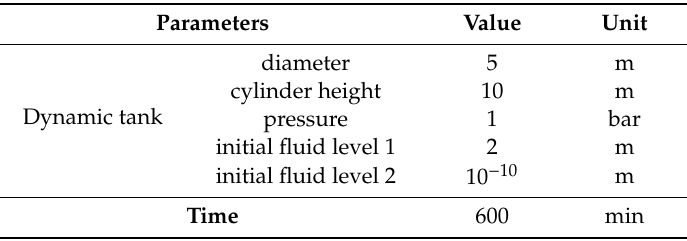
Table 7. Dynamic tank parameters.